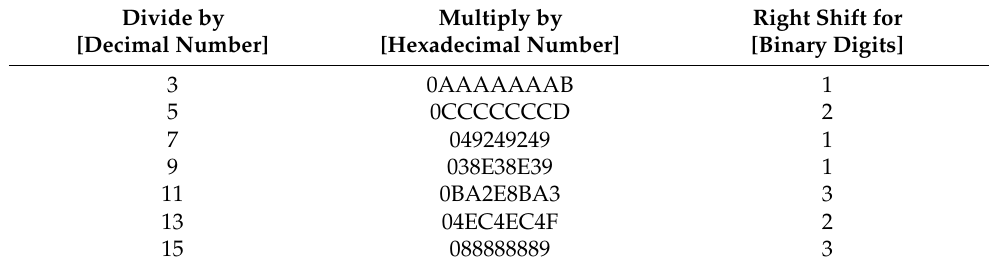
Figure 7. The flowchart of the proposed range decoder. Table 4. Implementation of division operation with numbers 3, 5, 7, 9, 11, 13 and